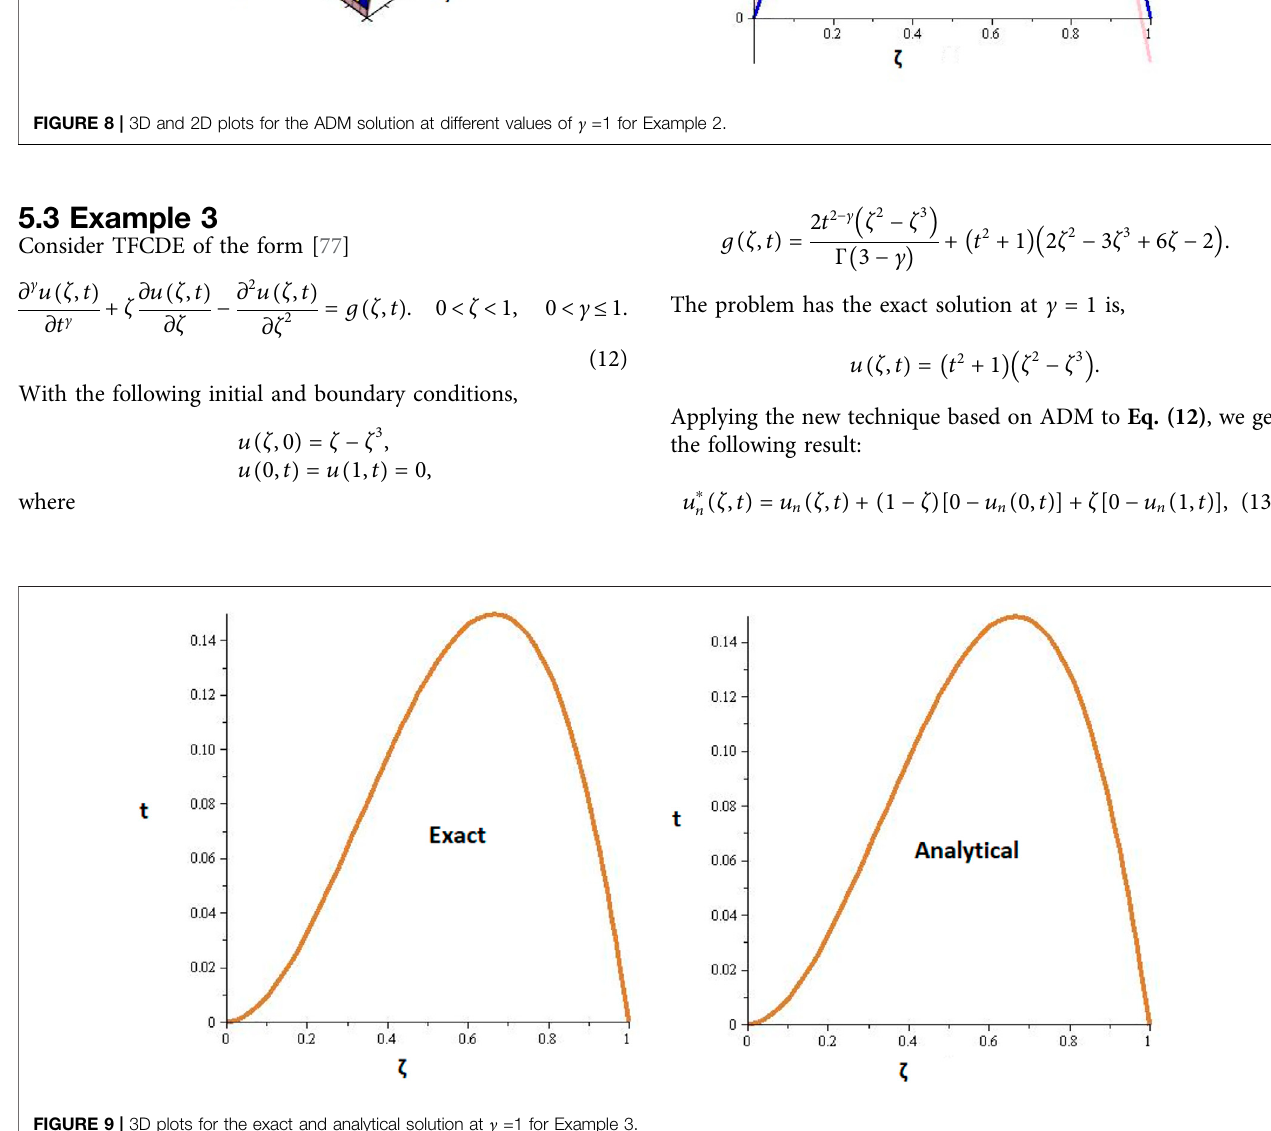
FIGURE 9 | 3D plots for the exact and analytical solution at γ =1 for Example